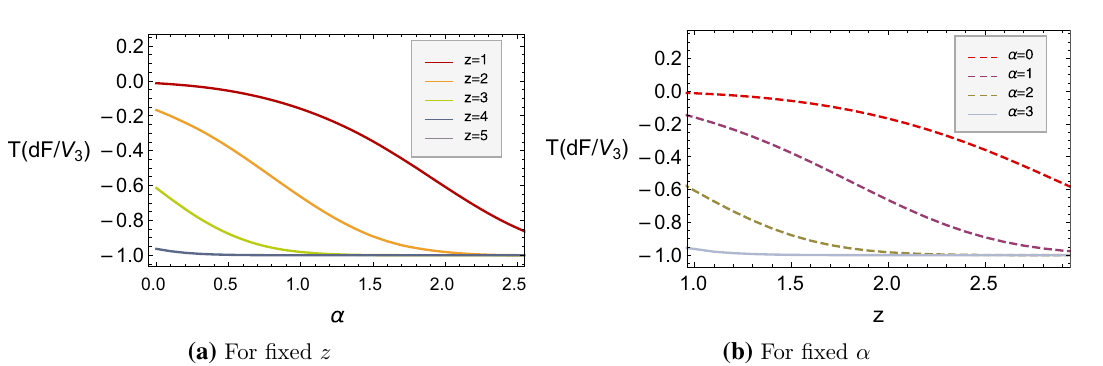
Fig. 3 Numerical fittings of ω(ξ) and b (ξ) functions